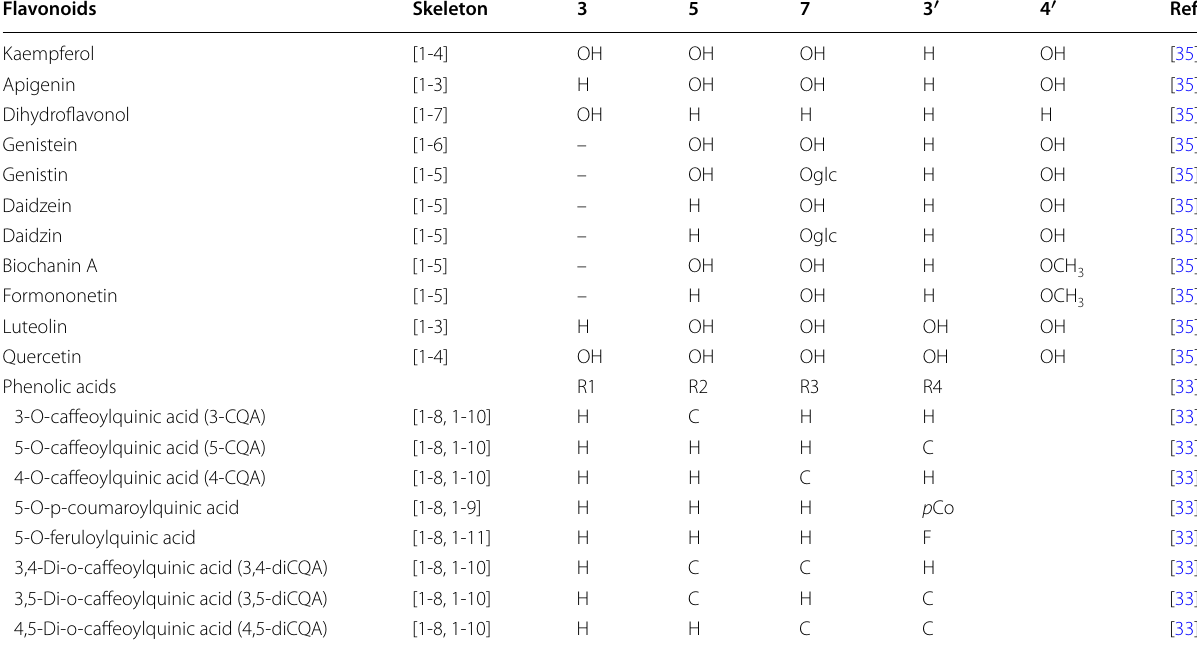
Oglc, glucosyl; p Co, p -coumaroyl